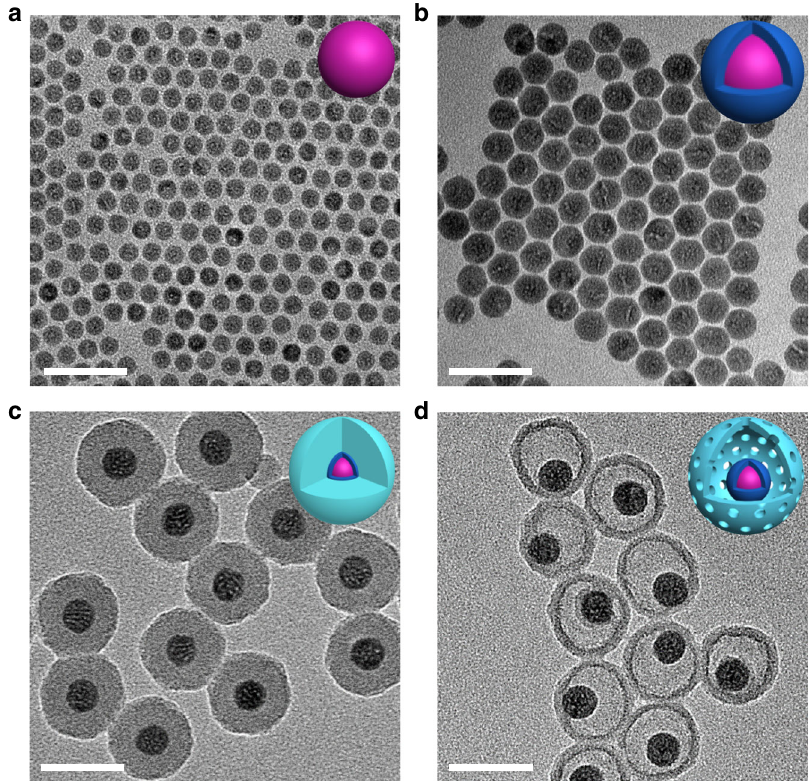
Fig. 2 Morphology characterization of the nanocomposite. TEM images of a NaLuF 4 :Yb,Er (UCNPs), b NaLuF 4 :Yb,Er@NaLuF 4 (csUCNPs), c NaLuF 4 :Yb,Er @NaLuF 4 @SiO 2 , and d NaLuF 4 :Yb,Er@NaLuF 4 @Yolk Shell-SiO 2 (YSUCNP). Scale bars were de fi ned as 50